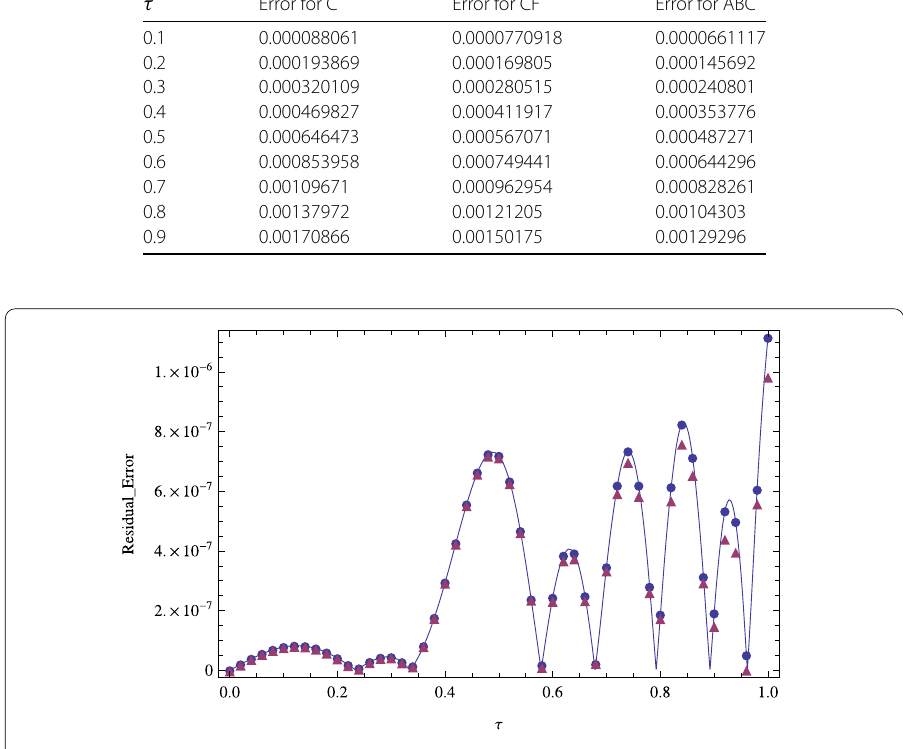
Figure 5 ARES by sixth-order approximations at β = 0.7, C ( • ), CF ( (cid:2) ), and ABC (–) for x ( τ